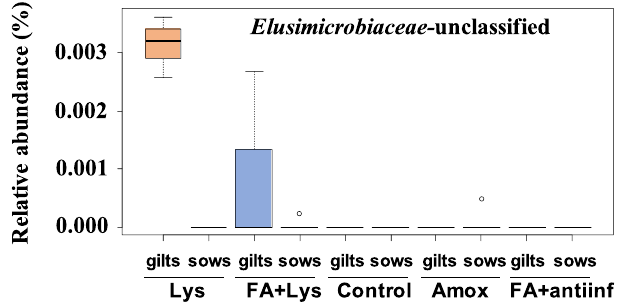
Figure 6. Analysis of composition of microbiomes (ANCOM) on fecal microbiota comparing groups considering the parity of the dams after treatment (D21). The ANCOM at amplicon sequence (ASV) level detected an unclassified genus from Elusimicrobiacea family with differential abundance when compared groups considering the parity of their dams. The mean relative abundance of this ASV is shown in percentage. The dotted lines represent standard deviation and outliers are indicated with white circles. The treatment groups were: Lys lysozyme, FA + lys medium chain fatty acids and lysozyme, C control, with no additives, Amox